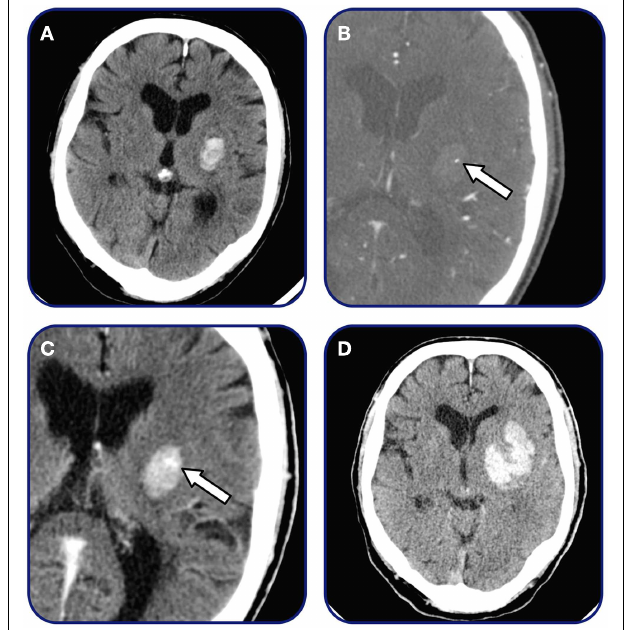
FIGURE 2 | Spot sign and contrast extravasation . Patient admitted within 2h after symptom onset. (A) Initial non-contrast CT demonstrating small basal-ganglia hemorrhage, (B) CTA source image demonstrating single spot sign (arrow), (C) 3-min post-contrast CT-imaging demonstrating contrast extravasation (arrow), and (D) 24h follow-up CT revealing final hematoma